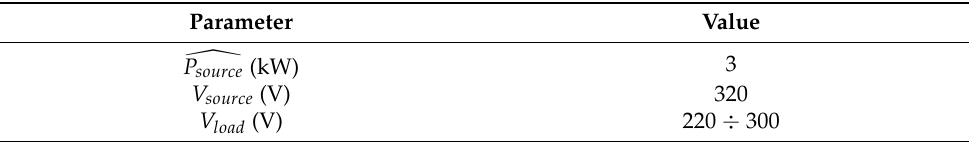
Table 2. Main electrical parameters of the experimental platform. Parameter